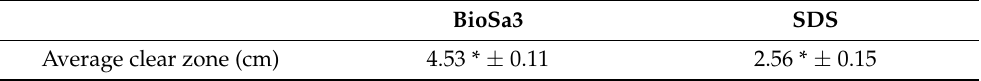
Table 1. Test results of oil displacement of the two BioSa3 producing strains. BioSa3 SDS Average clear zone (cm)